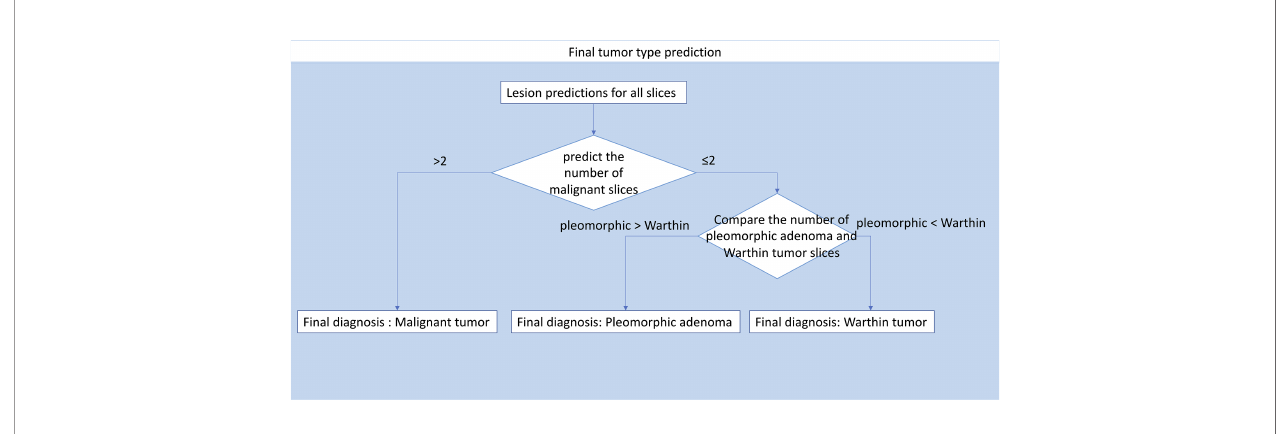
FIGURE 5 | Work fl ow integrating all slices to predict the fi nal diagnosis.